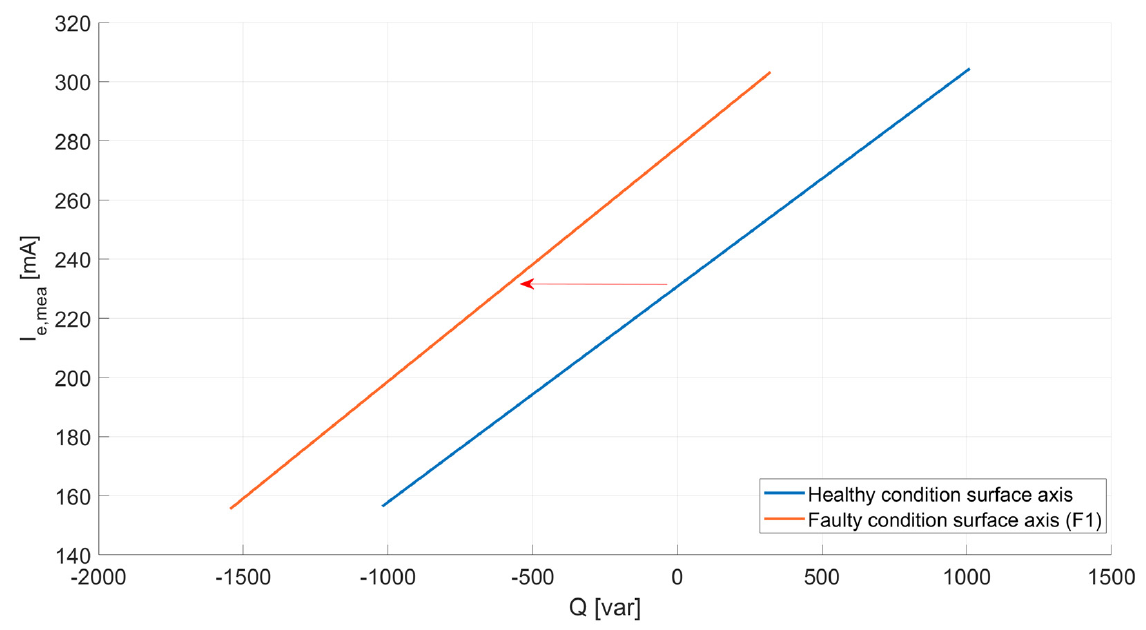
Figure 15. Experimental results. Representation of I e,mea healthy and faulty condition (F1: open-diode fault), surface axis for P = 1500 W at U = 400 V .